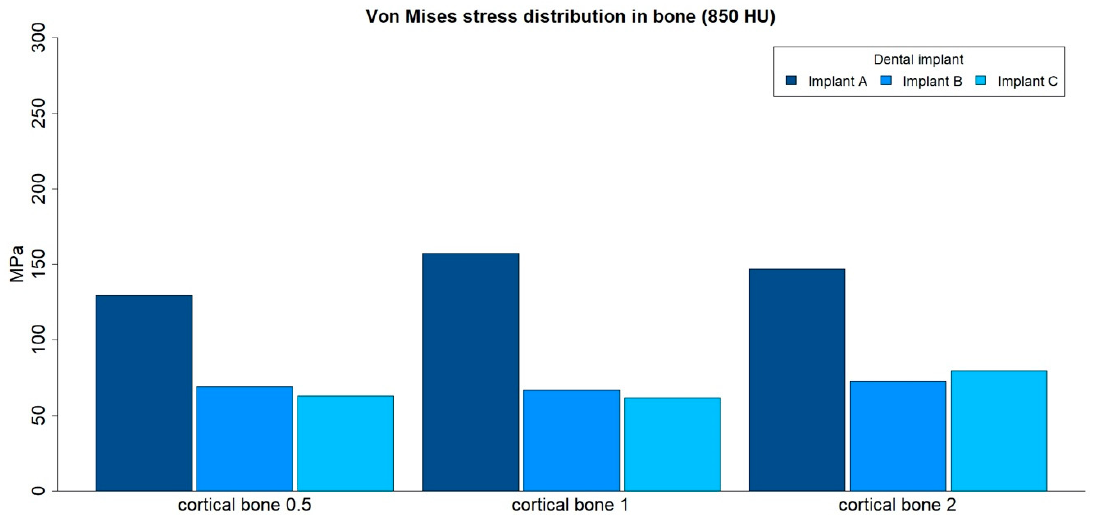
Figure 10. von Mises stress distribution (MPa) in high-density medullar bone (850 HU) for all cortical thicknesses (0.5 mm, 1 mm, and 2 mm) in all implant designs: A, B, and C. Table 4. von Mises stress distribution (maximum absolute values, MPa) in bone, for both medullar bone densities, for all cortical thicknesses (0.5 mm, 1 mm, and 2 mm) in all implant designs: A, B, and C.